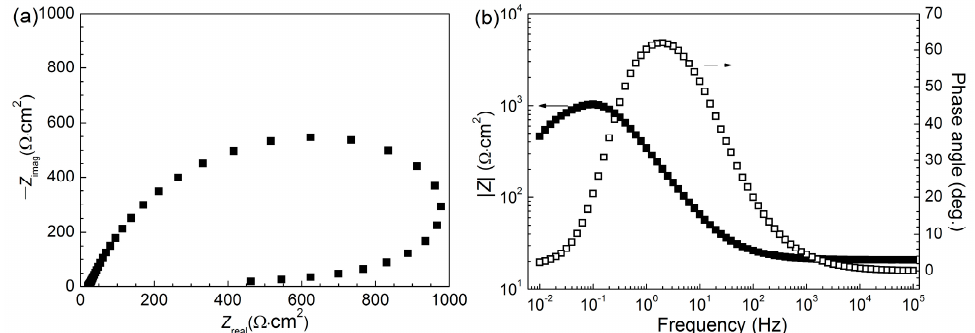
Figure 7. Nyquist spectrum ( a ) and Bode plots ( b ) of 65Mn steel after immersion in 3.5 wt.% NaCl solution for 30 min.